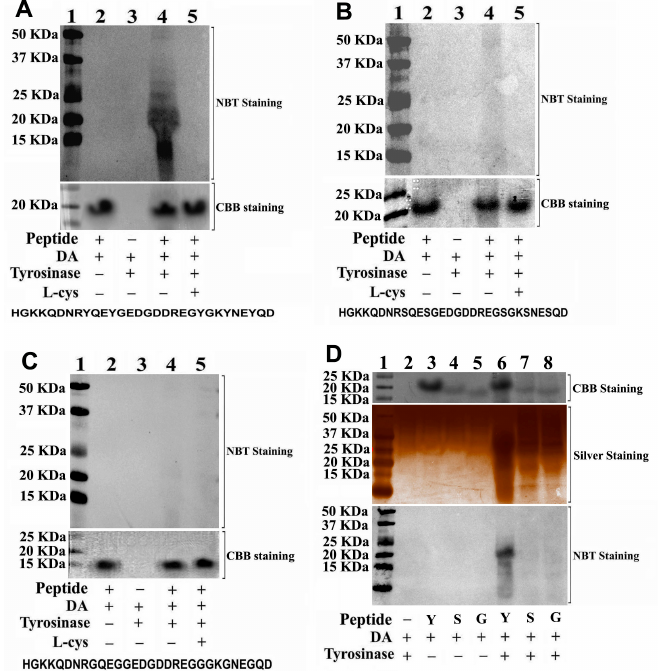
Figure 6. Conjugations of DA quinones (DAQ) to phenolic hydroxyl groups of synthesized peptides. Three peptides synthesized react with DA under tyrosinase catalysis in the presence or absence of L -cys. After reaction, peptides are precipitated and analyzed by SDS-PAGE, visualized by nitroblue tetrazolium (NBT), silver, and CBB R-250 staining respectively. ( A ) Peptide Y with 5 phenolic hydroxyl groups (tyrosine residues) can react with DAQ well in solutions, ( B ) peptide S with 5 non-phenolic hydroxyl groups (serine residues) have poor capability to react with DAQ. ( C ) Peptides G with no hydroxyl groups (glycine residues) have poor capability to react with DAQ in solutions. ( D ) Comparison of reactions capability of 3 peptides with DAQ.